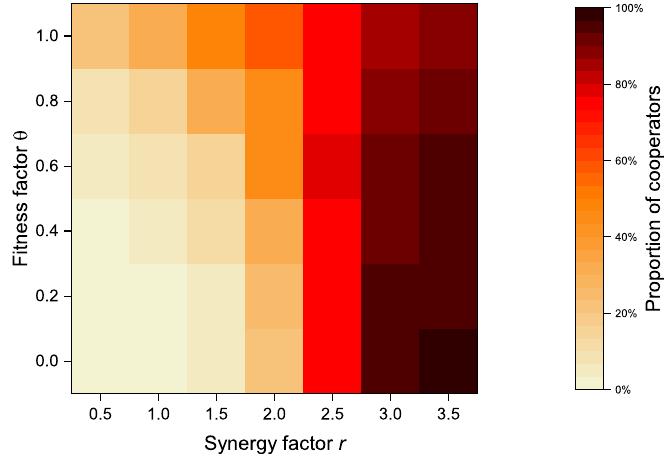
Figure 8. Relationship between fitness factor θ and synergy factor r of the model when the proportion of altruistic nodes is set to 50%.